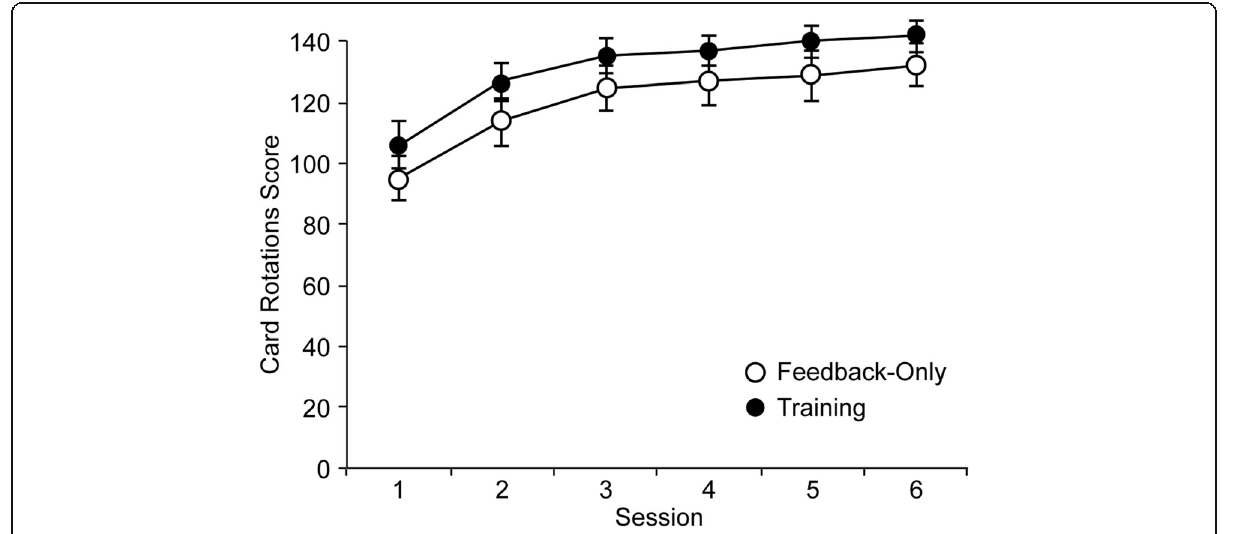
Fig. 5 Results of a mixed analysis of variance for Card Rotations scores. Vertical lines depict standard errors of the